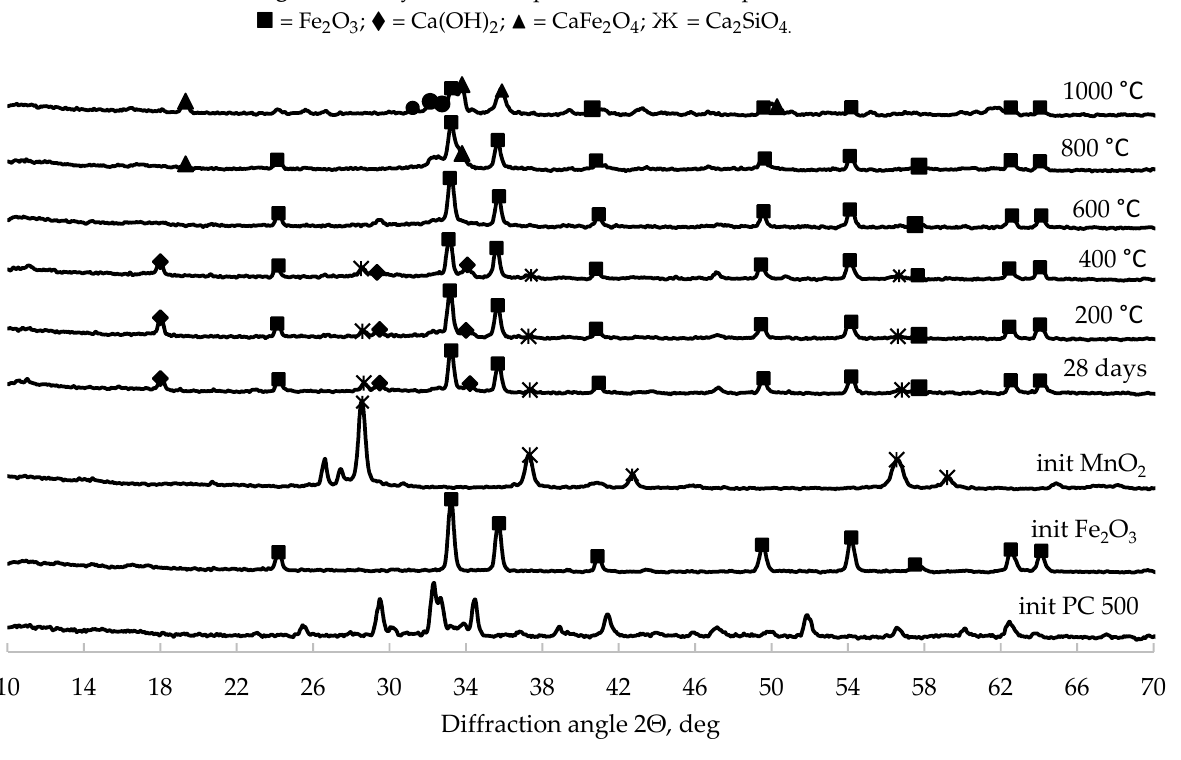
Figure 8. X-ray di ff raction pa tt ern of concrete specimens based on PCfm mix after heat treatment: ■ = Fe 2 O 3 ; ◊ = Ca(OH) 2 ; ● = Ca 2 SiO 4 ; ▲ = CaFe 2 O 4 ; * = MnO 2.